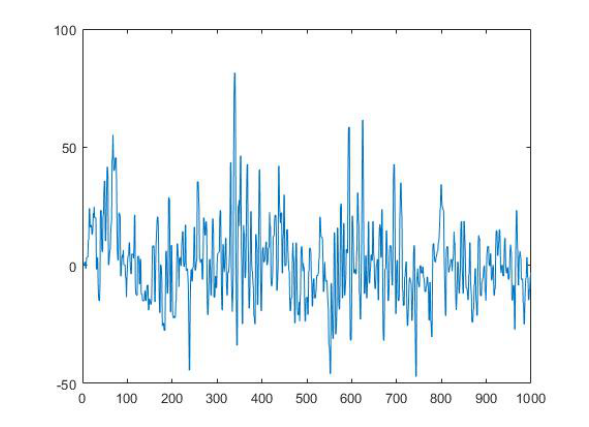
Figure 15. chb04-01 Median Filter Output